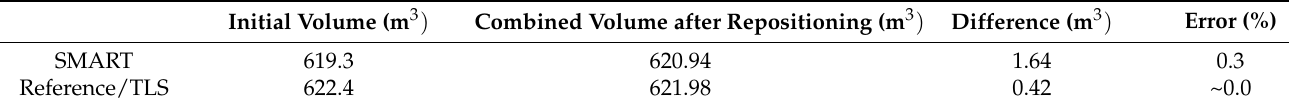
Table 10. SMART and TLS volumes for the right pile before/after repositioning.